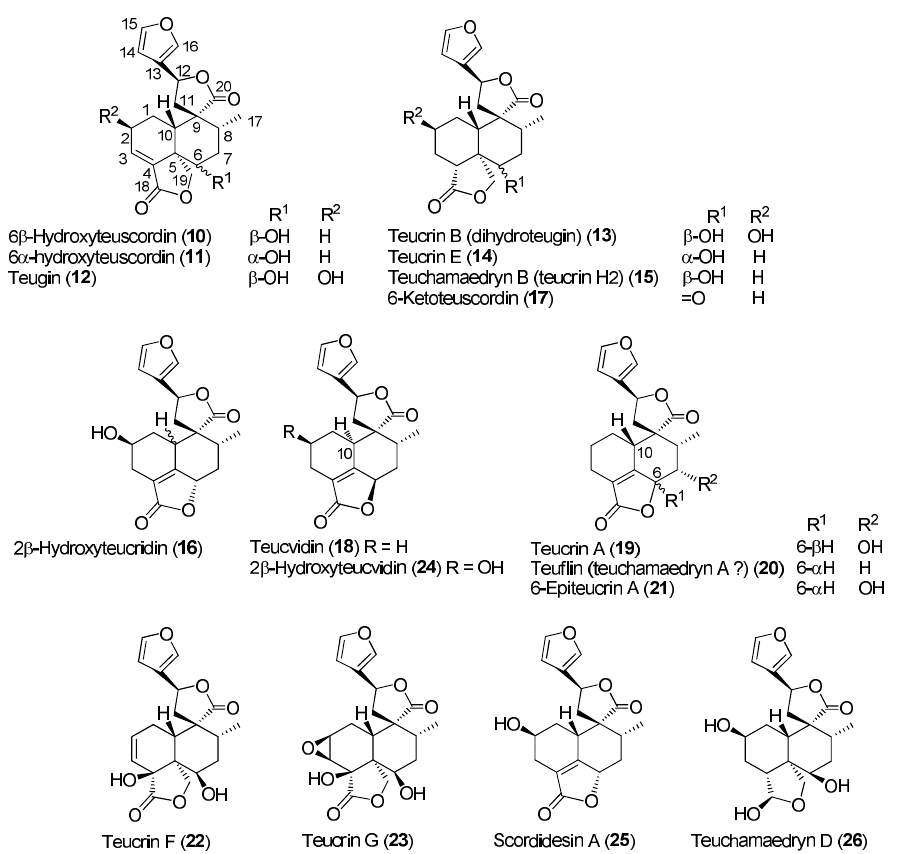
Figure 3. Representative neo-clerodane diterpenoids isolated from Teucrium chamaedrys and Teucrium scordium subspecies scordioides .